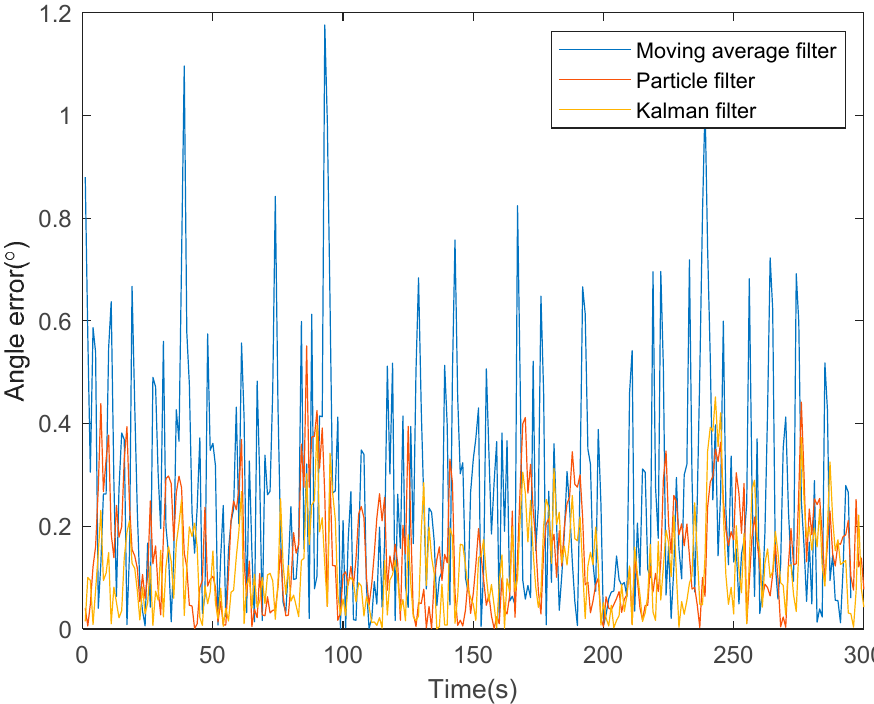
Figure 5. Parallel four-bar linkage rotation angle filtering error.